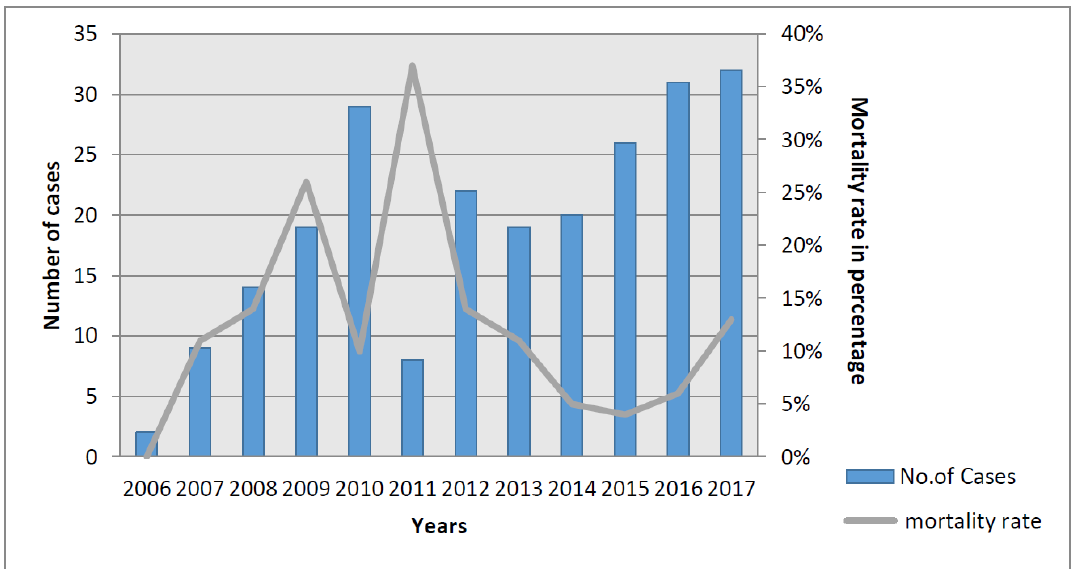
Figure 2. Annual numbers of melioidosis cases and mortality from Manipal.